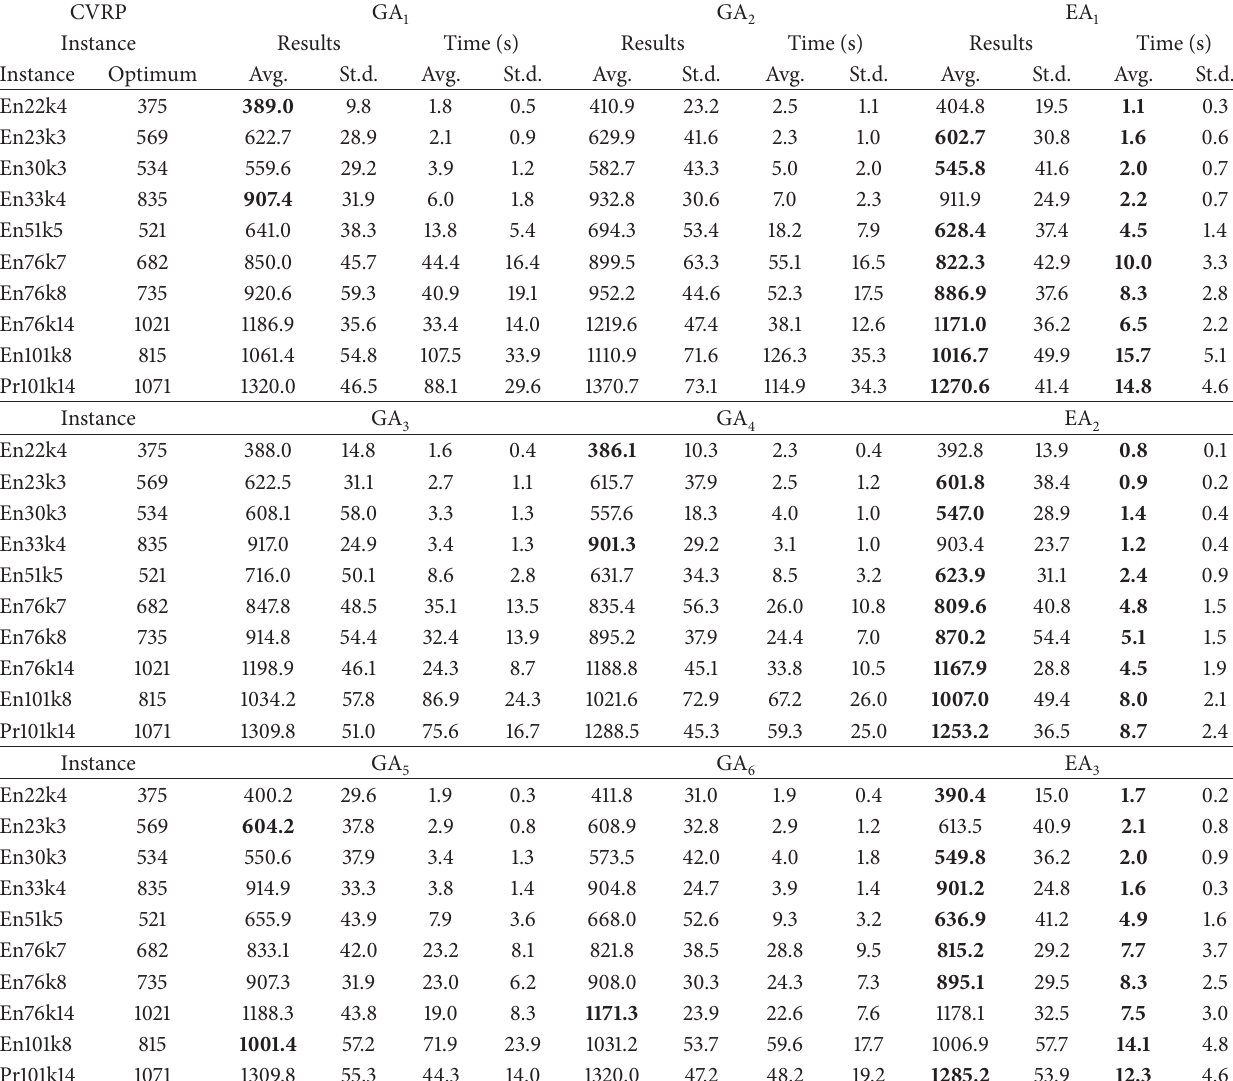
Table 5: Results and runtime of the nine techniques applied to the CVRP. For each instance, the results, average runtime, and their standard deviations are